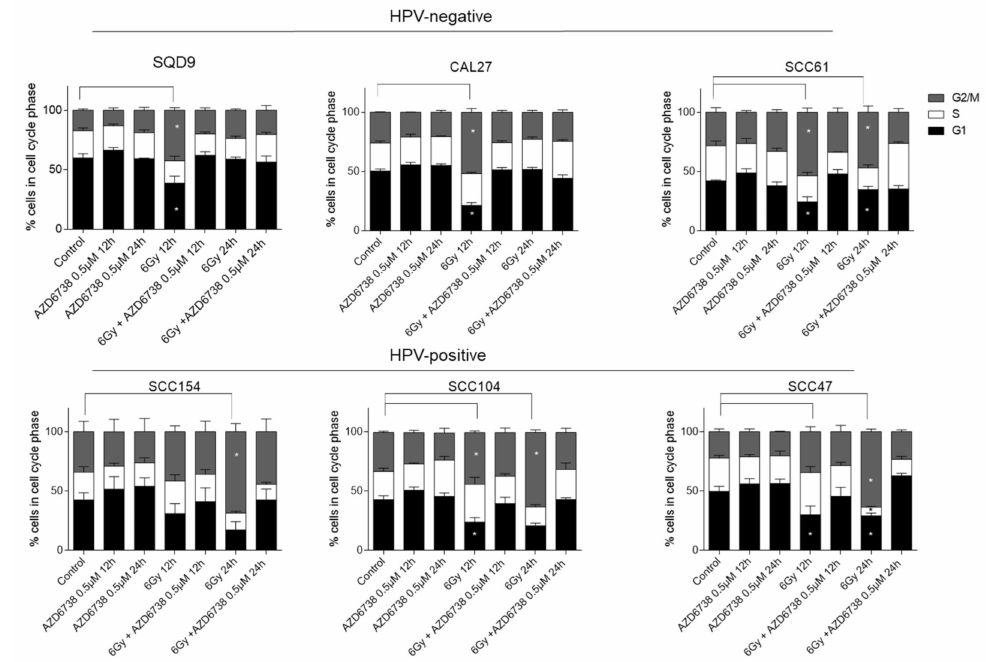
Figure 3. Effect of ATR inhibition on cell cycle progression. The percentage (%) of HPV-negative (SQD9, CAL27, and SCC61) and HPV-positive (SCC154, SCC104, and SCC47) HNSCC cells distributed in cell cycle phases after treatment with 0.5 µ M AZD6738 and/or 6Gy of RT. In all the drug-treated conditions, the AZD6738 is incubated for 12 h and 24 h. For the combination treatment conditions, AZD6738 is given 2 h before RT and is removed after 12 and 24 h. The indicated time points on the x-axis indicate the time after drug and/or RT exposure. Data are represented as the mean ± SEM, n = 3. * p -values were calculated with two-way ANOVA with Tukey’s multiple correction.